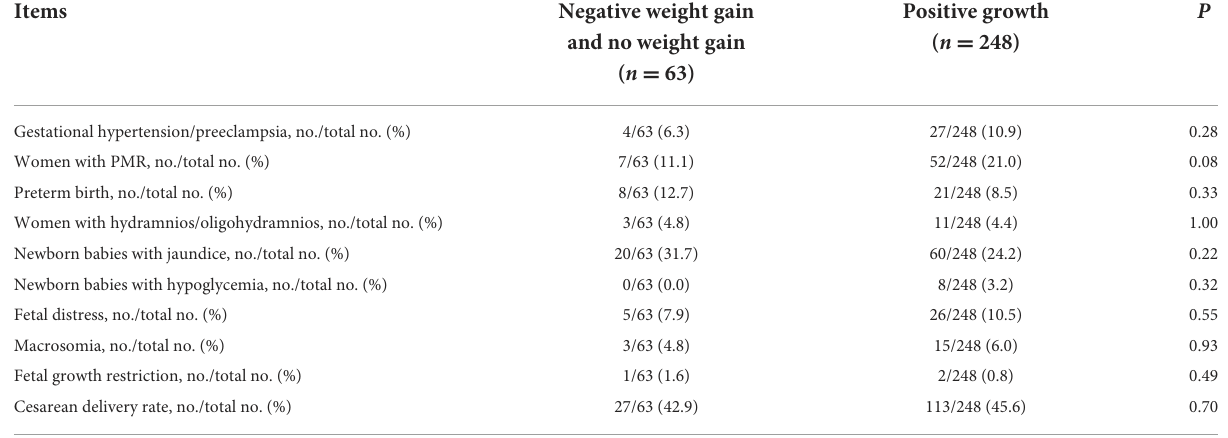
TABLE 5 Influence of weight change on pregnancy outcomes after 1 day of the outpatient clinic (X ± S).